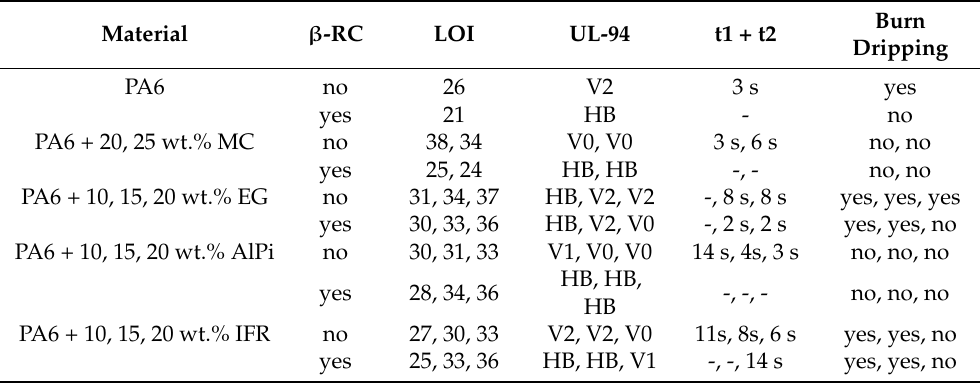
Table 4. LOI and vertical UL-94 burning test results—summary.